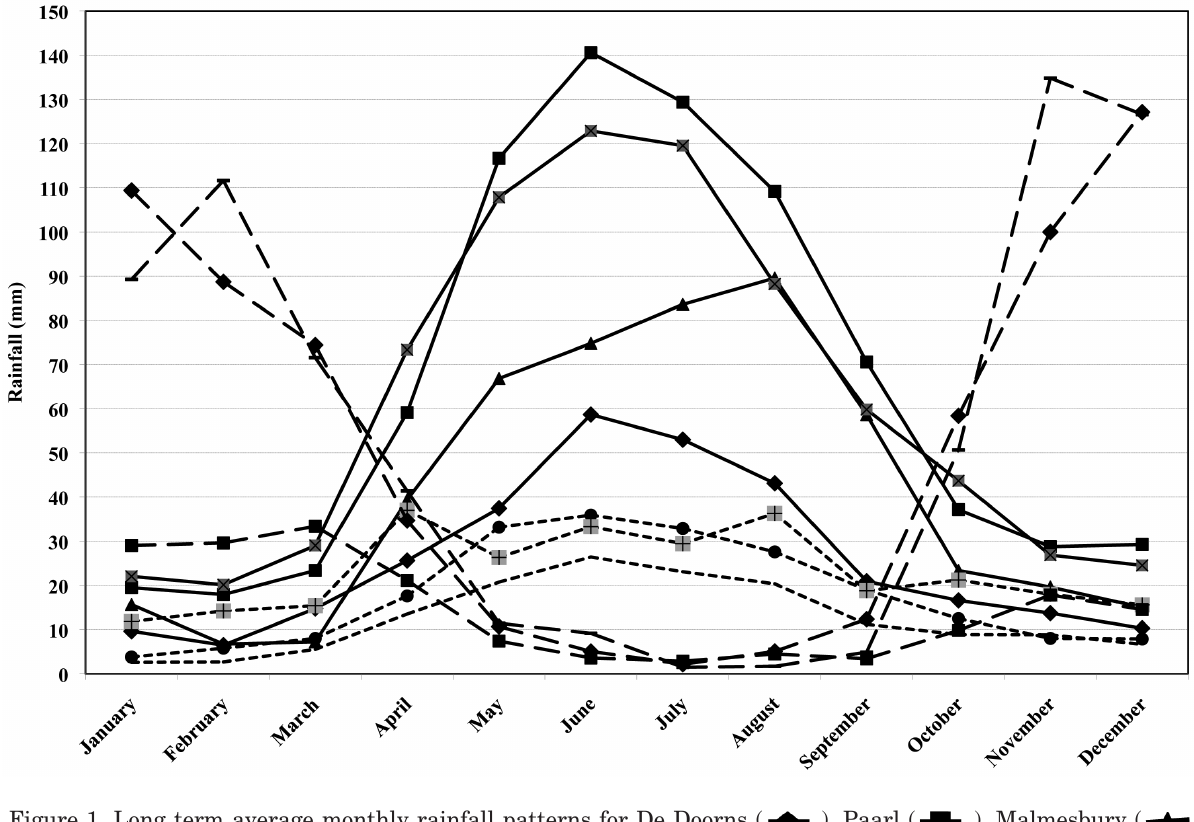
Figure 1. Long term average monthly rainfall patterns for De Doorns